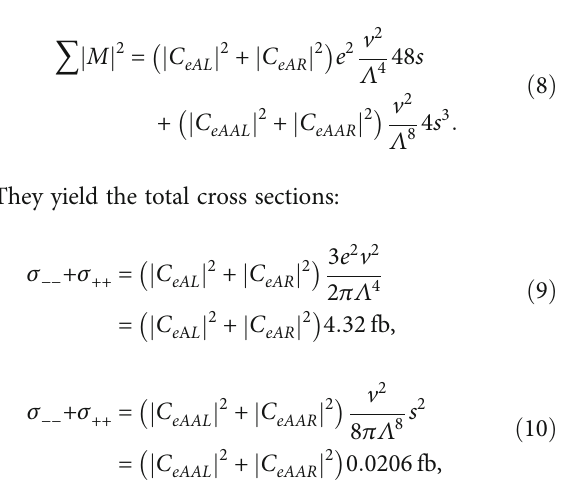
Figure 1: The anomalous two-to-two process e − μ + ⟶ γγ . Process (a) ( t -channel) as given by the trivalent vertex dipole operator Q Process (b) as given by the contact term, dimension 8 operator Q